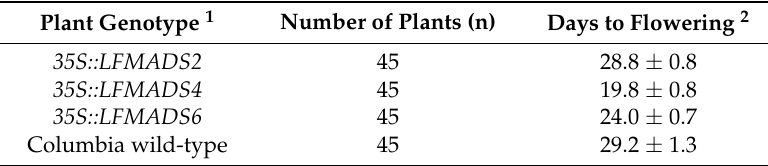
Table 2. Bolting time of the transgenic 35S::LFMADS2 , 35S::LFMADS4 , and 35S::LFMADS6 plants compared to wild-type (Columbia ecotype).